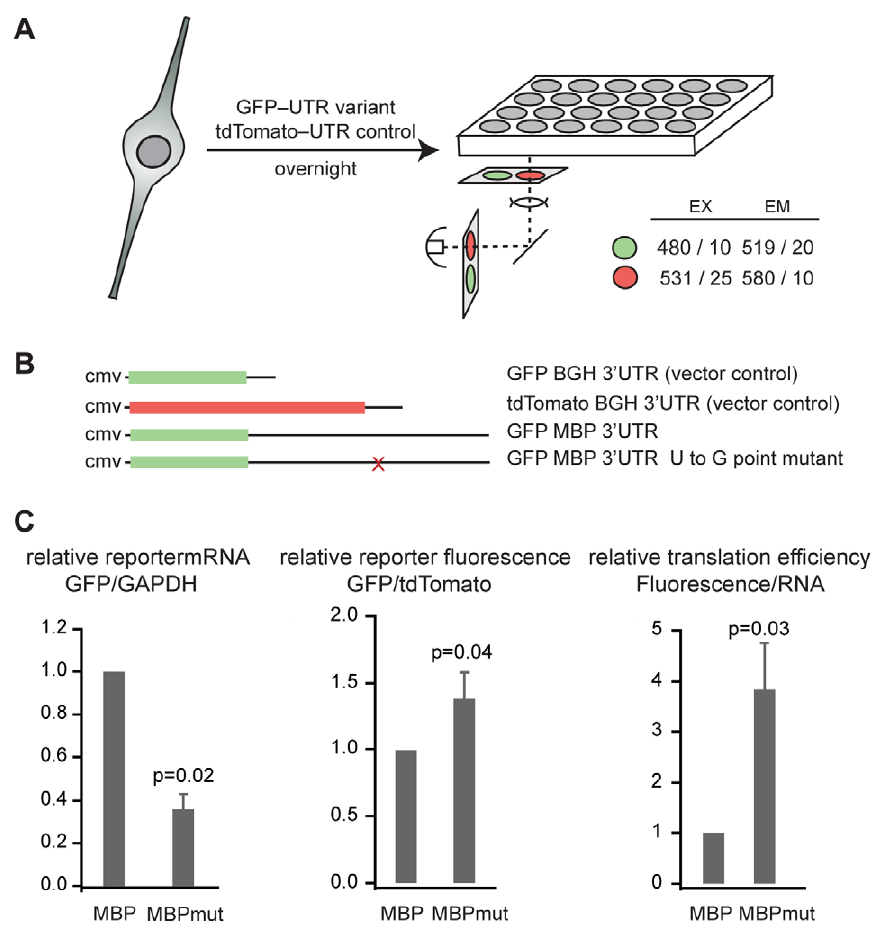
Figure 1. The QSBE is a regulatory element in the Mbp 3 9 UTR. (A) Schematic drawing of the fluorescence reporter assay. (B) Constructs used in reporter assays. The Mbp 3 9 UTR or the Mbp 3 9 UTR with the U to G point mutation were inserted into the 3 9 UTR of phrGFPII-1. tdTomato was unmodified and served as a transfection control. (C) tdTomato and GFP mRNA level were measured by real time RT-PCR from cells co-transfected with the indicated GFP construct and the tdTomato transfection control. The data in the graph are the average and standard deviation of six replicates from two independent experiments. The ratio of green to red fluorescence intensity was determined from nine replicates in three independent experiments. The graph represents the average and standard deviation. The normalized reporter fluorescence was divided by the normalized reporter mRNA to obtain a measure of translational efficiency. Error bars represent the error propagated from the standard deviation of the reporter fluorescence and real time RT-PCR